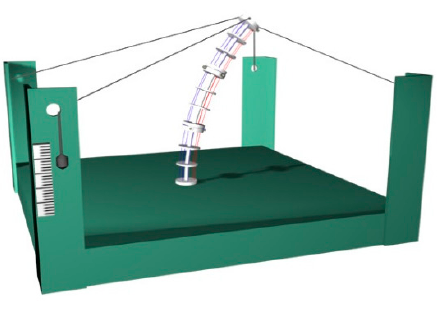
Figure 10. Sketch of the test bench.